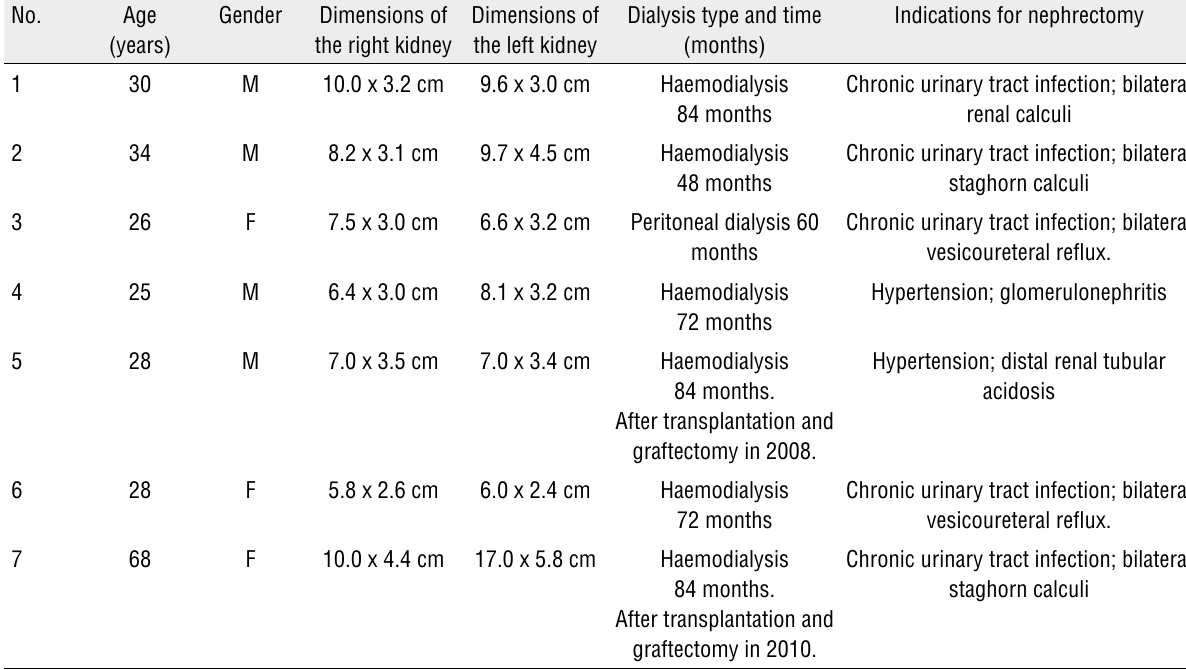
Table 1 - Characteristics of patients enrolled in the study.